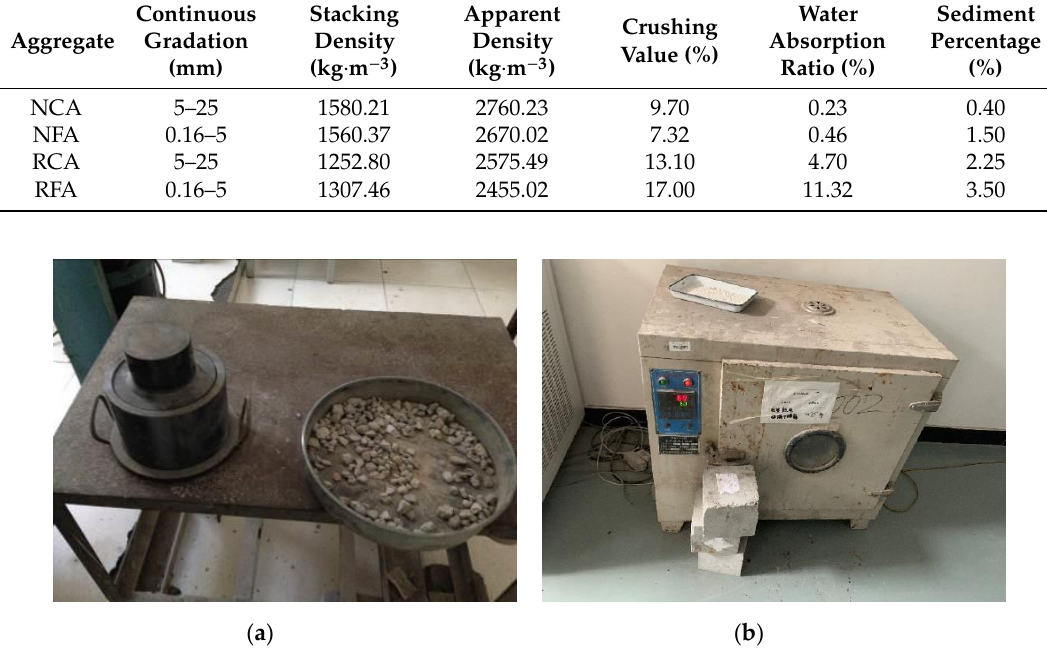
Figure 4. Instruments used for measuring the basic properties of the aggregates . ( a ) Crushing index; ( b ) Water absorption.